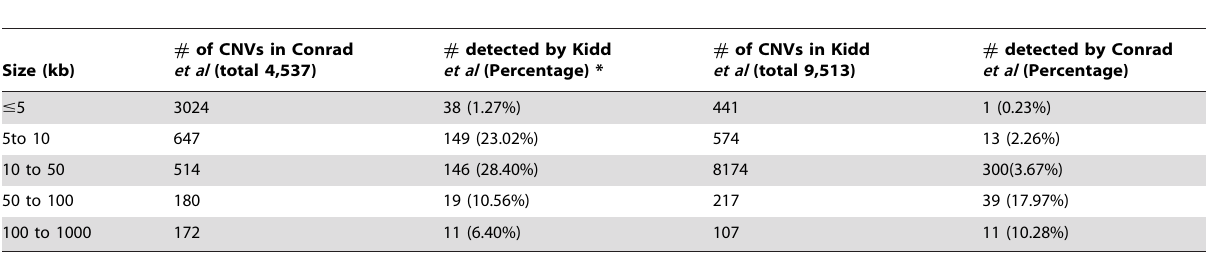
Table 4. CNVs detected in 8 HapMap individuals shared between two